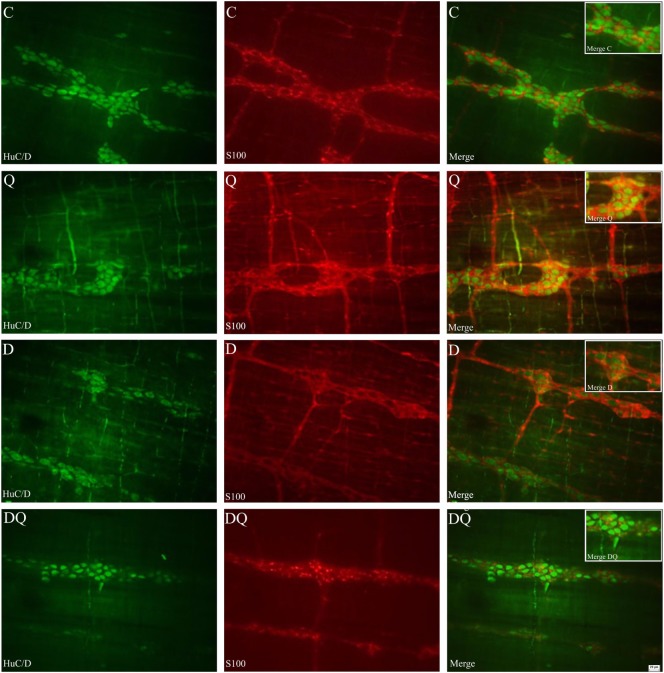
Representative photomicrographs that illustrate the whole mounts of jejunal myenteric plexus stained by immunohistochemical technique for HuC/D-immunoreactive neurons (first column) and S-100- immunoreactive glial cells (middle column). The third column illustrates the overlapping of the images of the neurons and enteric glial cells. The following groups were used: normoglycemic control (C), normoglycemic control supplemented with quercetin (Q), diabetic (D), and diabetic supplemented with quercetin (DQ). Scale bar = 20 µm.